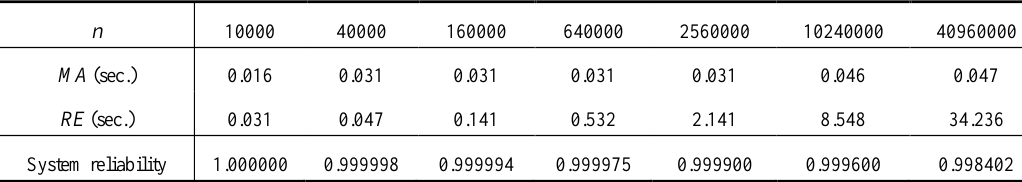
Table 1. Comparison of calculating time when m =5, r = 4, s = 12 and p = 0.4